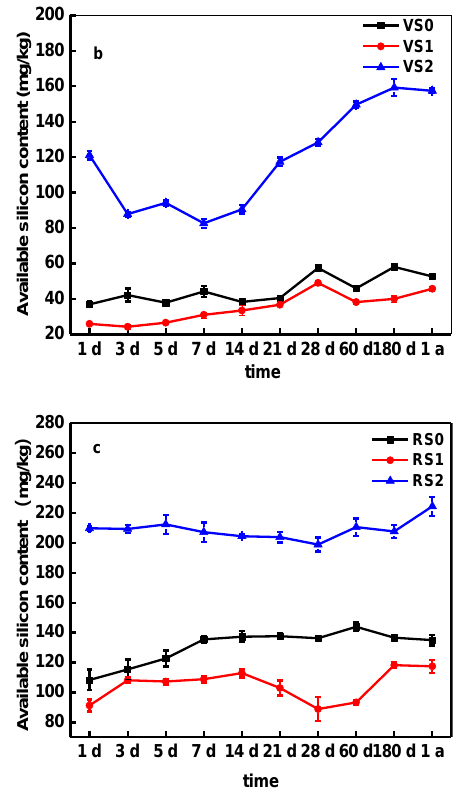
Figure 4. The change of available silicon content in BS ( a ), VS ( b ) and RS ( c ) soils amended with biochars. Note: Error bars are standard deviations of the means ( n = 3).